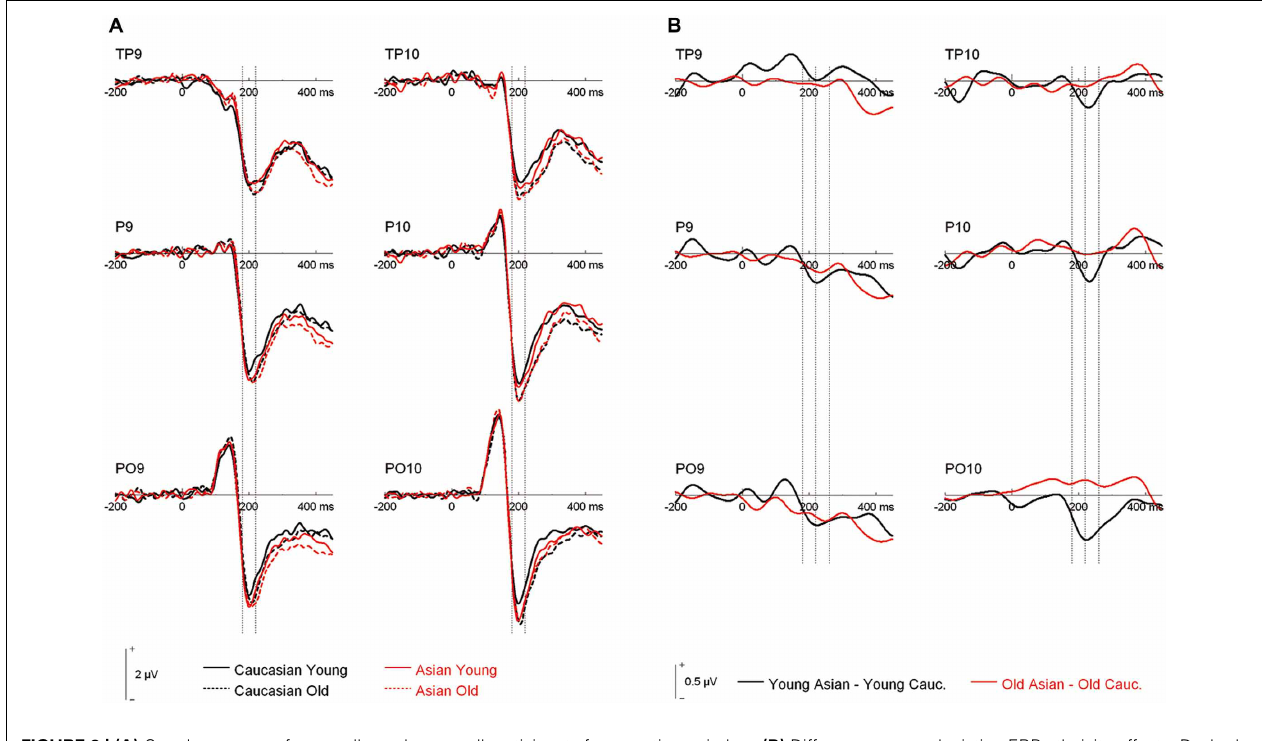
FIGURE 2 | (A) Grand mean waveforms collapsed across all participants for young and older Asian and Caucasian faces from the learning phases of the recognition memory experiment. Dashed lines depict the 180–220ms (N170)